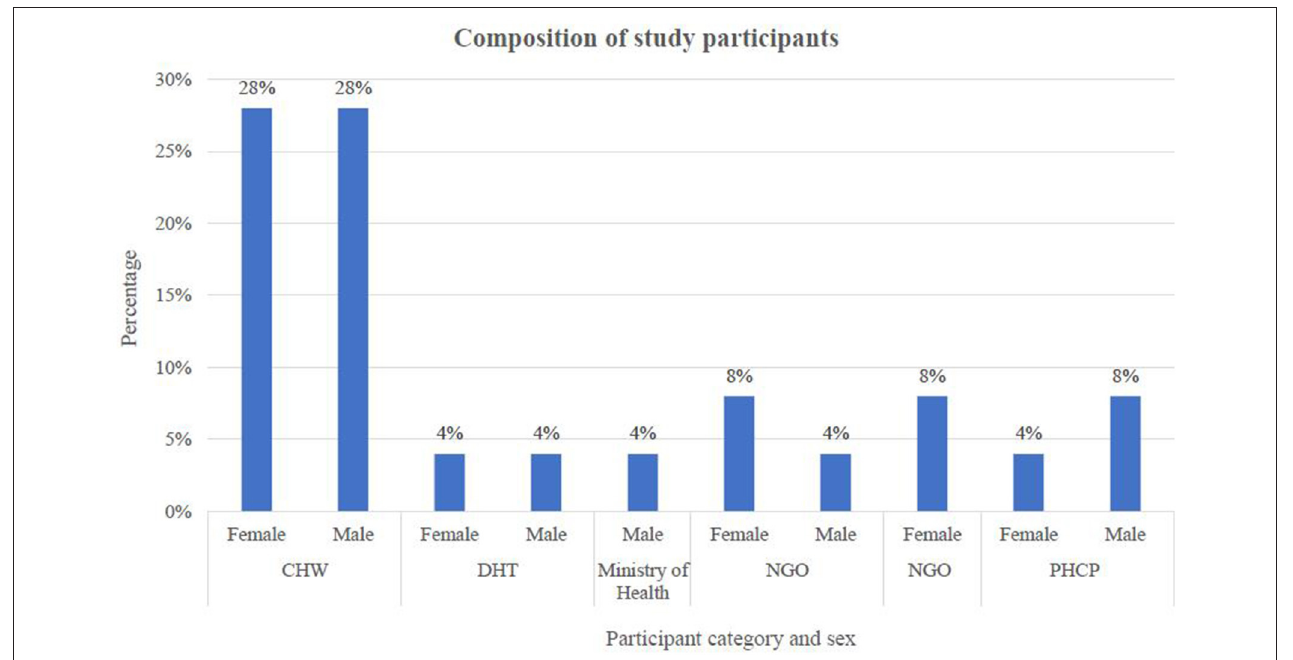
FIGURE 2 | Composition of study participants involved in the